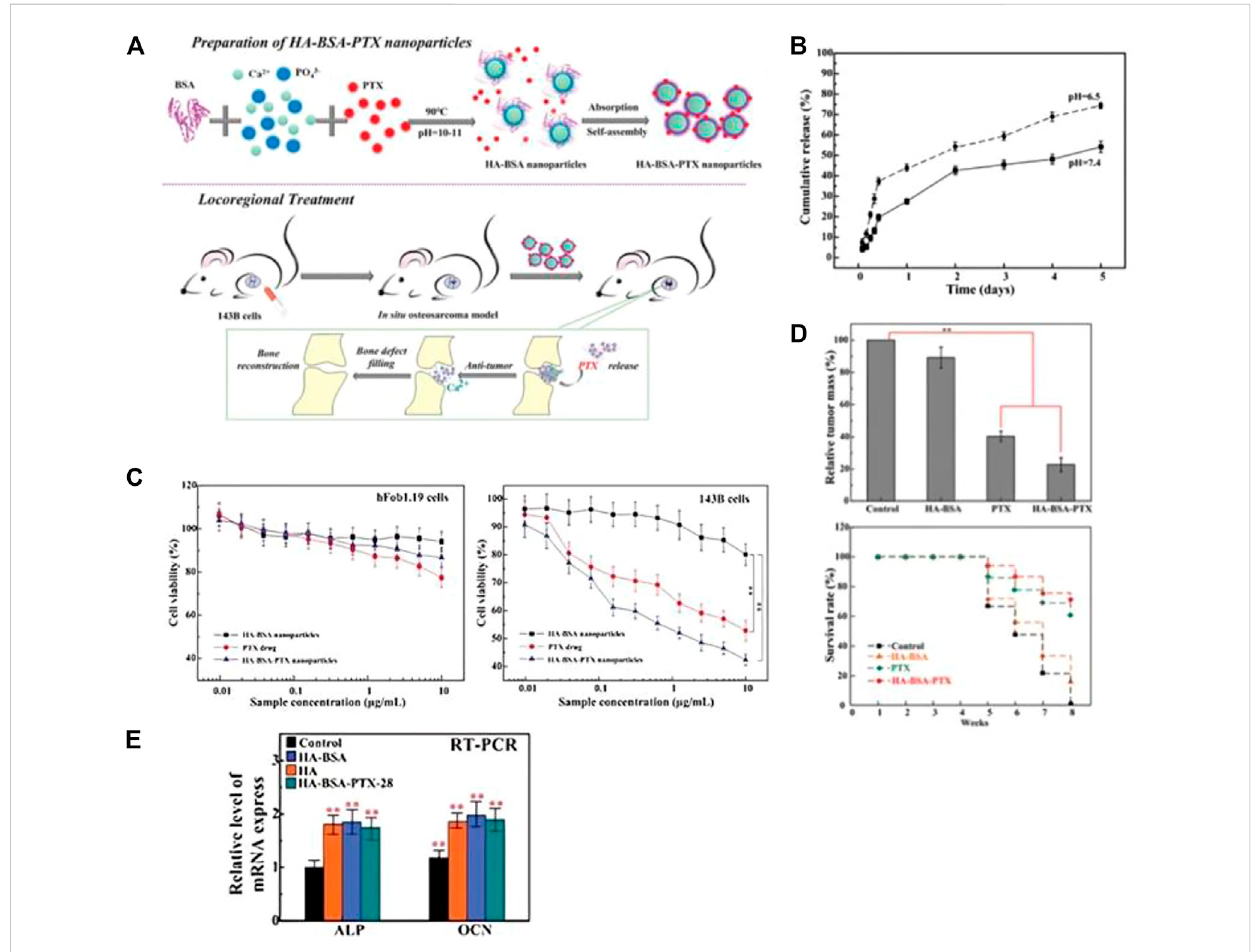
FIGURE 2 (A) SchematicdiagramofthepreparationprocessofHA-BSA-PTXnanoparticlesandtheexperimentaldesignofthe invivo osteosarcomamodel. (B) In vitro drug release evaluation of HA-BSA-PTX nanoparticles in PBS solution at pH 7.4 and 6.5 with Tween 80 (0.1%, v/w). (C) MTT assay was used to evaluate the in vitro toxicityof HA-BSAnanoparticles, freePTX,and HA-BSA-PTX nanoparticleson hFob1.19cells and 143B cells. Withincreasing dosage, HA-BSA-PTX nanoparticles showed the best toxicity to 143B cells and lower toxicity to hFob1.19 cells than PTX alone. (D) Weight of osteosarcoma tissuetreatedwithcontrol(PBS),HA-BSAnanoparticles, PTXalone,andHA-BSA-PTXnanoparticles,andsurvivaltimeofnudemice. (E)